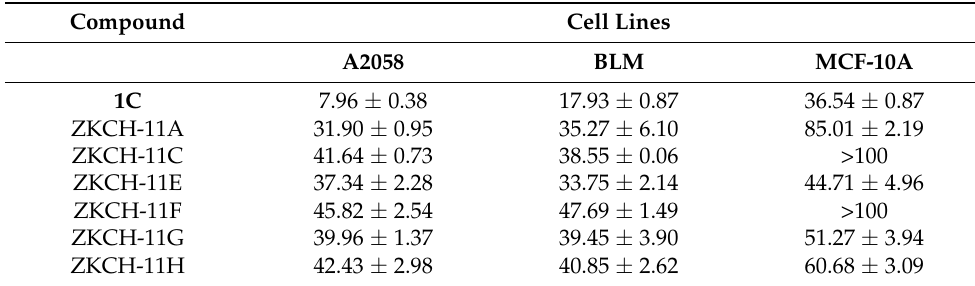
Table 1. IC50 ( µ mol/L) of tested compounds in different cell lines after 72 h incubation.